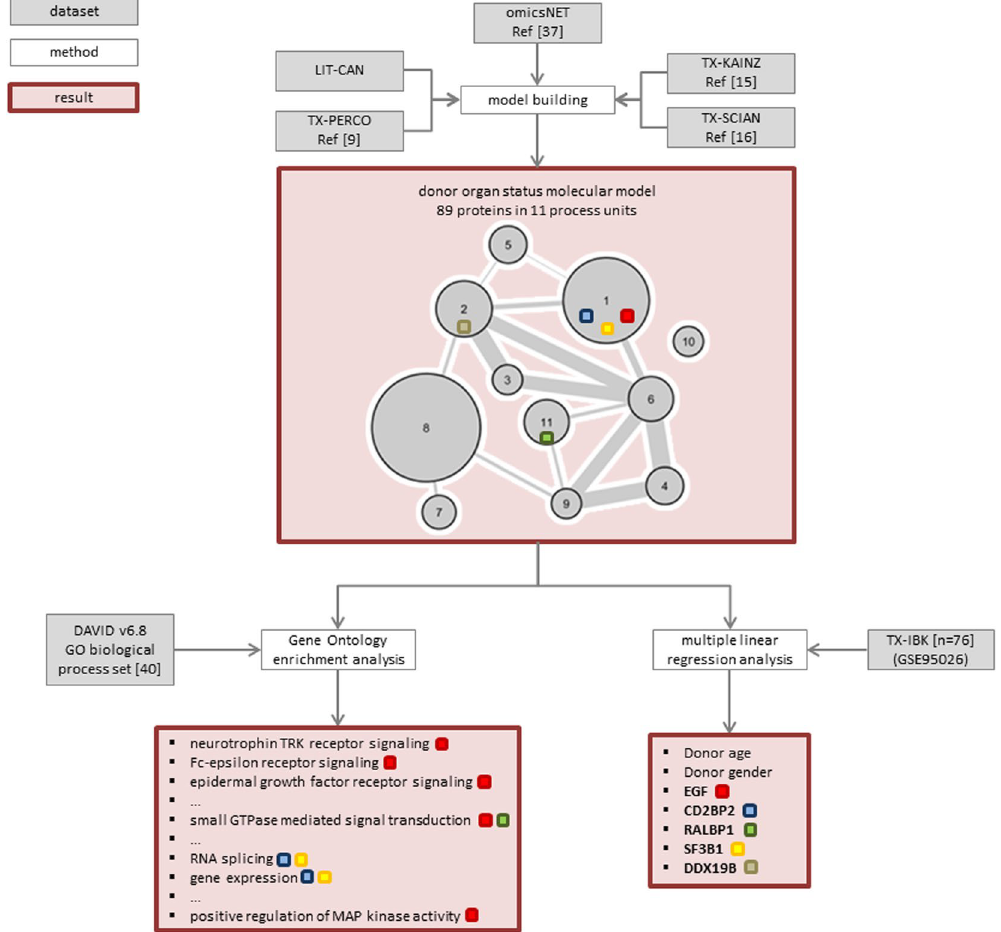
Figure 1. Data analysis workflow and results. Schematic representation of the data analysis workflow with used datasets, methods, and results indicated by grey, white, and red boxes respectively. Assignment of molecular markers to molecular model process units as well as enriched GO biological processes based on molecular model input features is indicated by colored